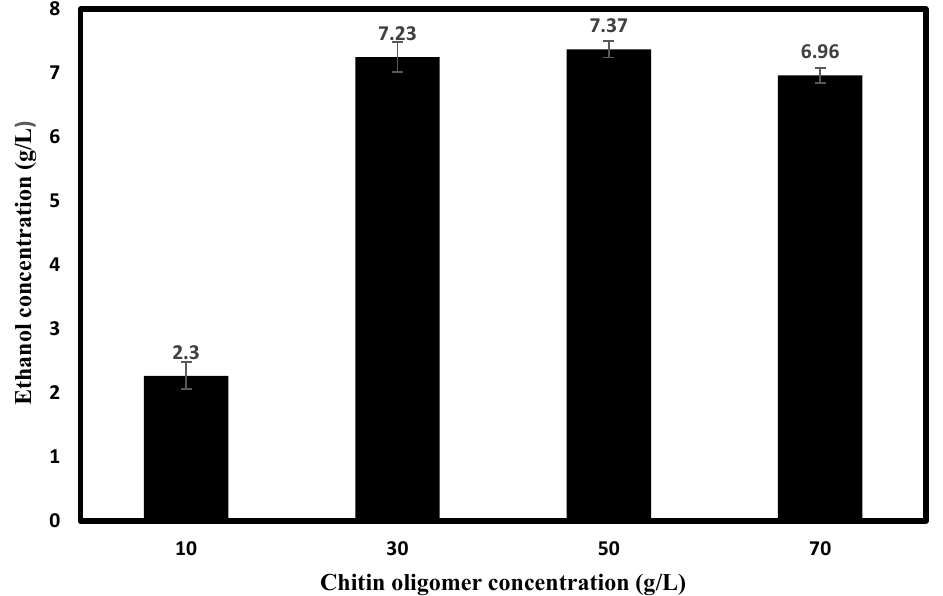
Figure 5. Effect of substrate concentration on ethanol production from chitin oligomer by M. circinelloides.